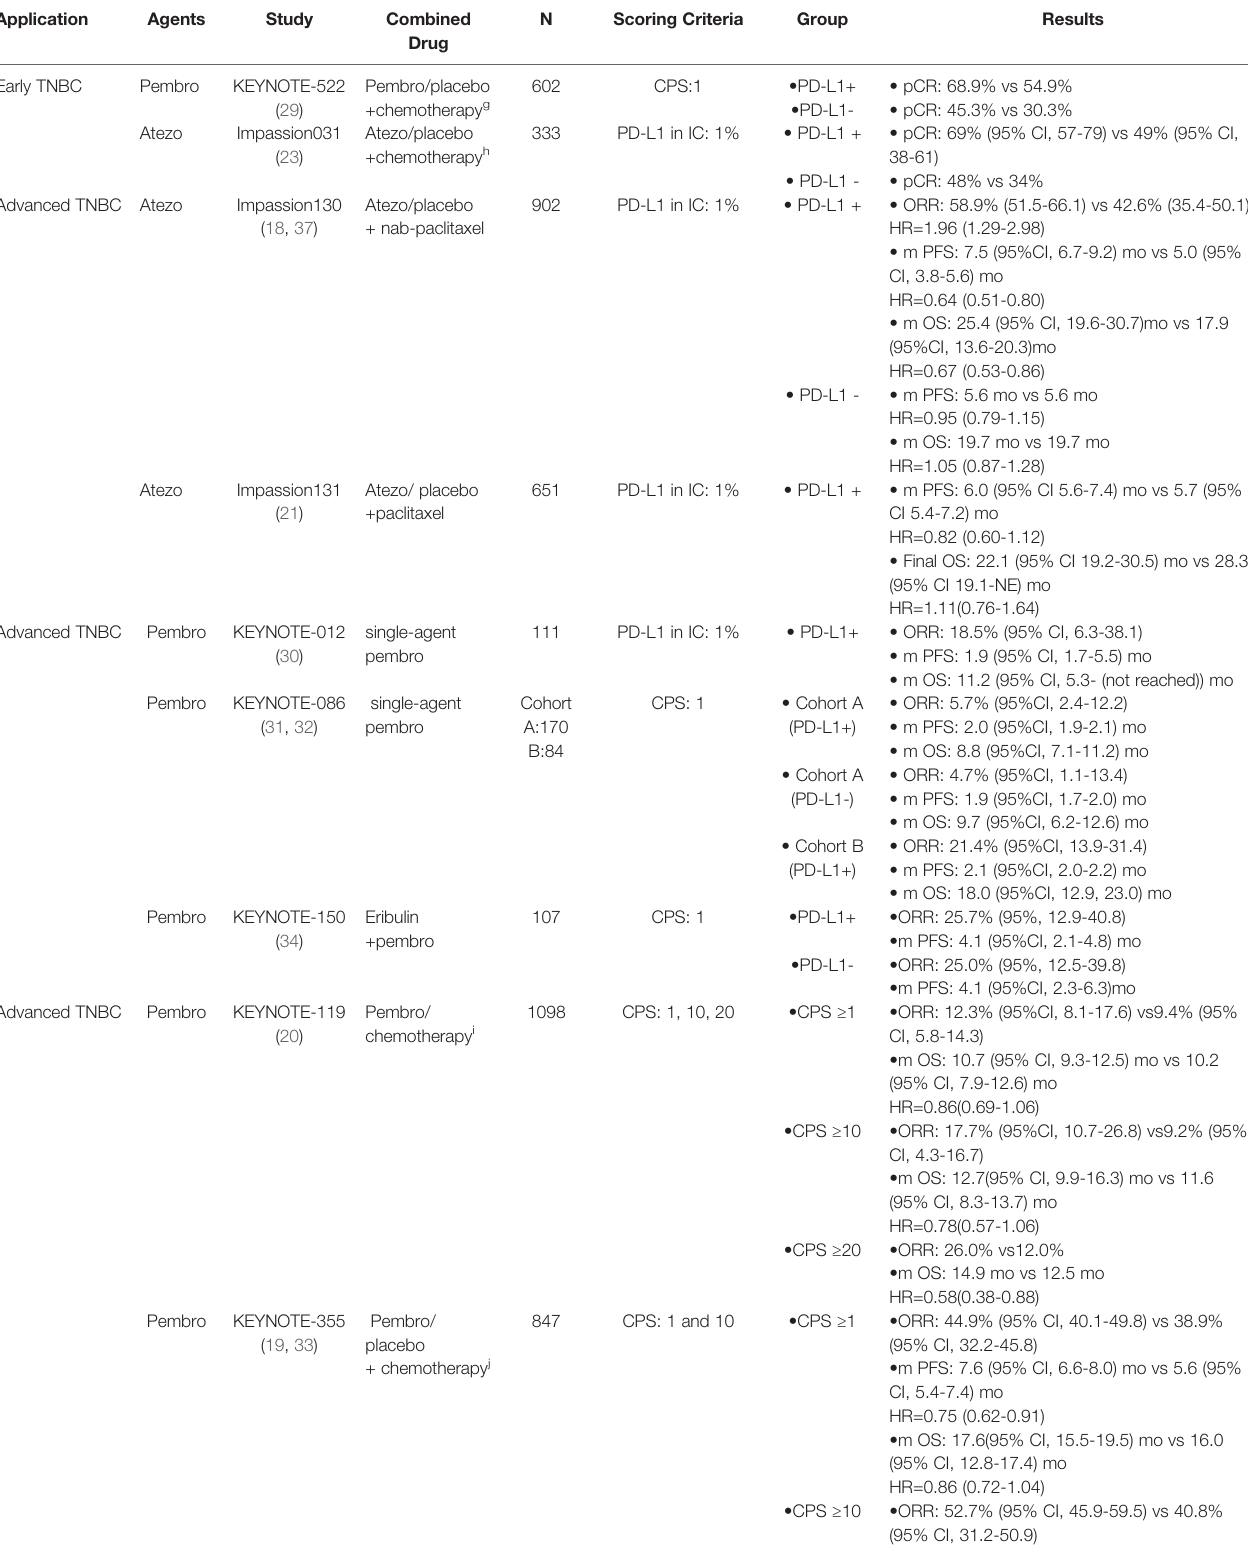
TABLE 2 | The predictive value of PD-L1 for PD-1/PD-L1 inhibitors in TNBC.